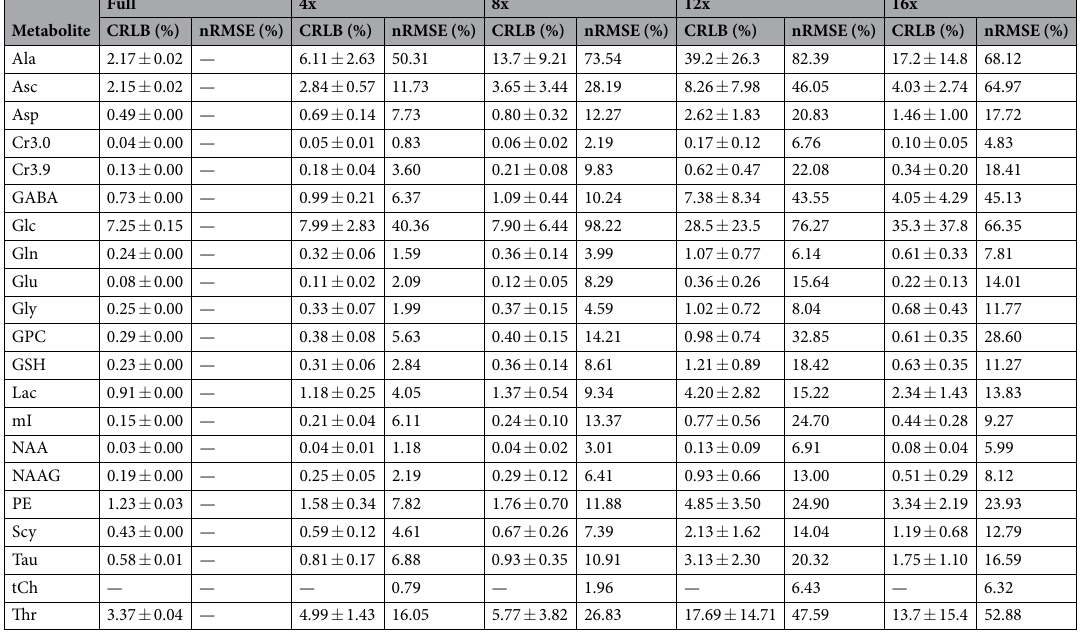
Table 1. The mean ± standard deviation CRLB values and normalized root mean square errors comparing the fully sampled and accelerated 5D EP-JRESI vphantom measurements are tabulated as percents. Many CRLB% values remain well below the 20% threshold typically used for quality control.